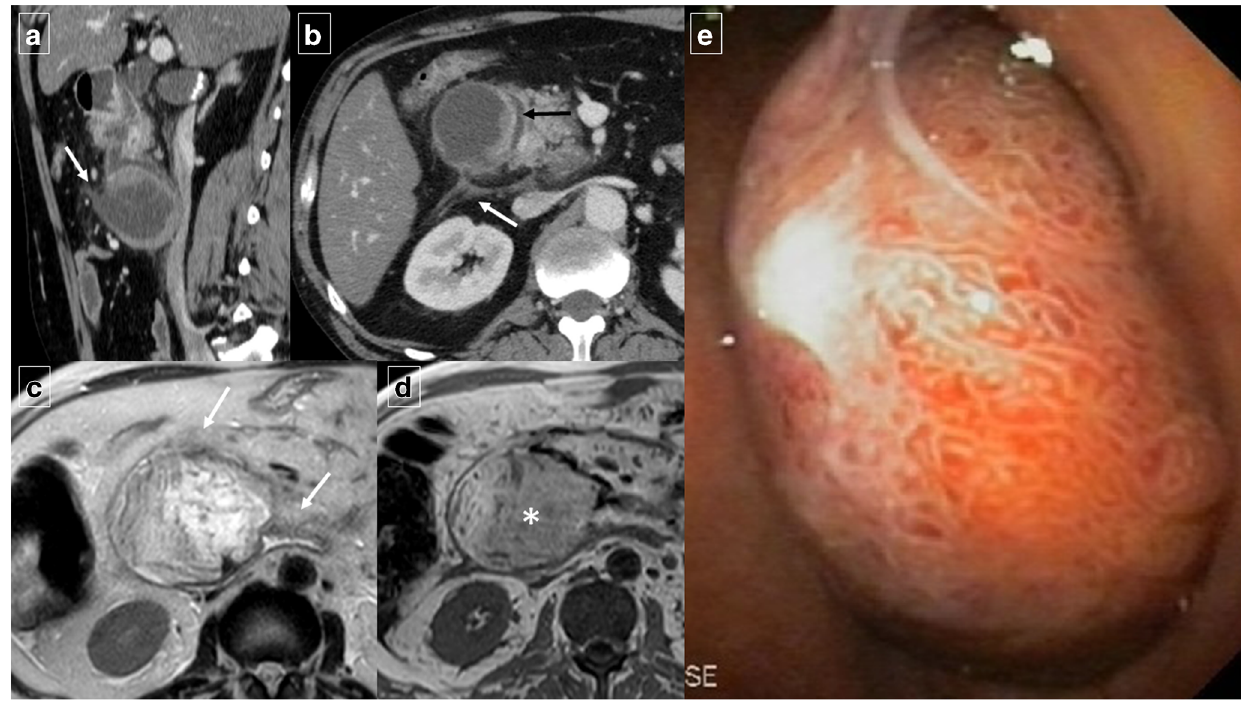
Fig. 2 Ruptured duodenal duplication cyst in a 58-year-old man who sustained blunt trauma in a fall down stairs. a Reformatted sagittal contrast-enhanced CT shows circumferential wall thickening of the cyst and a disruption in its anterior surface (arrow). b Axial CT shows retroperitoneal fluid in the right anterior pararenal space (white arrow). The duodenal lumen is narrowed and displaced medially due to